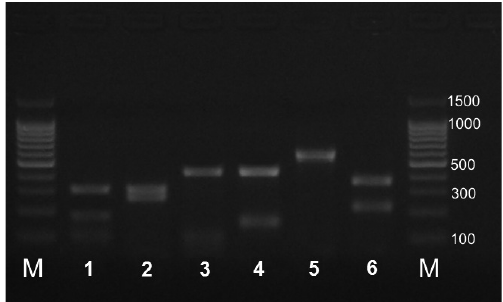
Figure 9. Restriction fragments of COI PCR products (restriction enzyme, species): 1 AhlI , E. maura or E. testudinaria 2 AhlI , E. integriceps 3 PsiI , E. maura or E. testudinaria 4 PsiI , E. integriceps 5 Bst2UI , E. maura or E. testudinaria 6 Bst2UI , E. integriceps ; M, 100 bp DNA